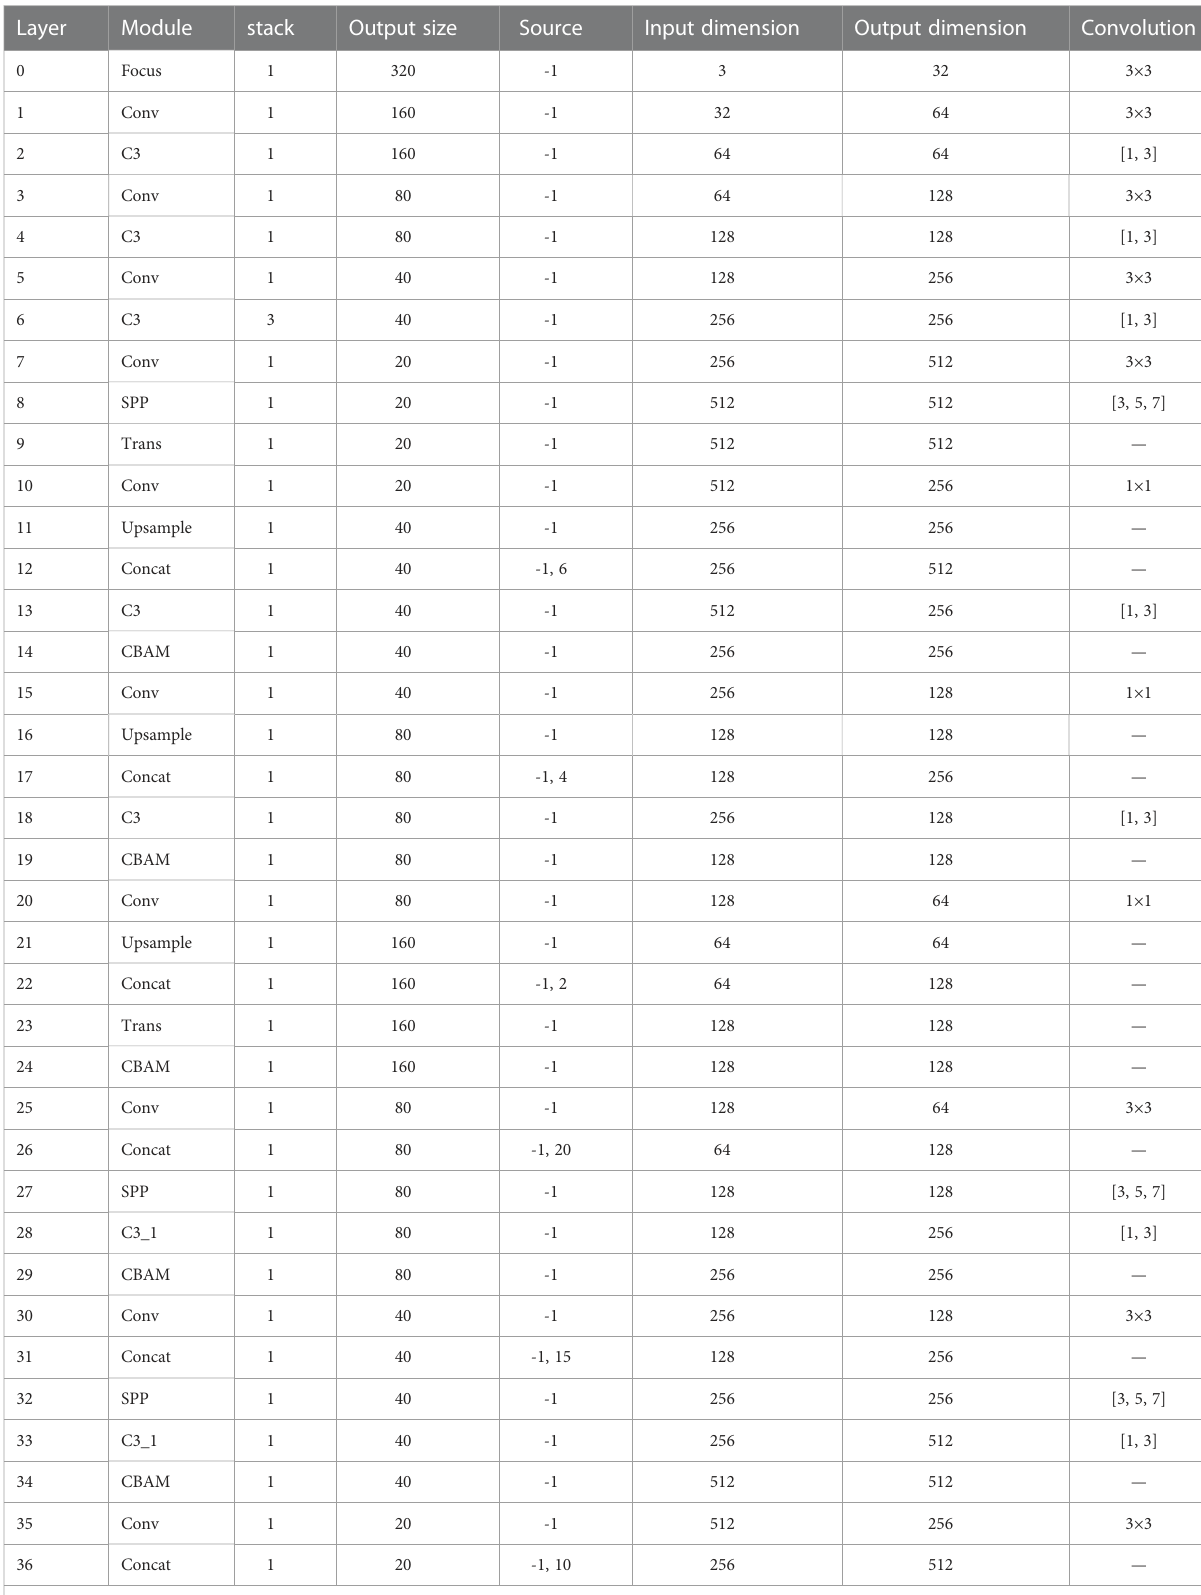
TABLE 1 Improved layer parameters of YOLOv5s